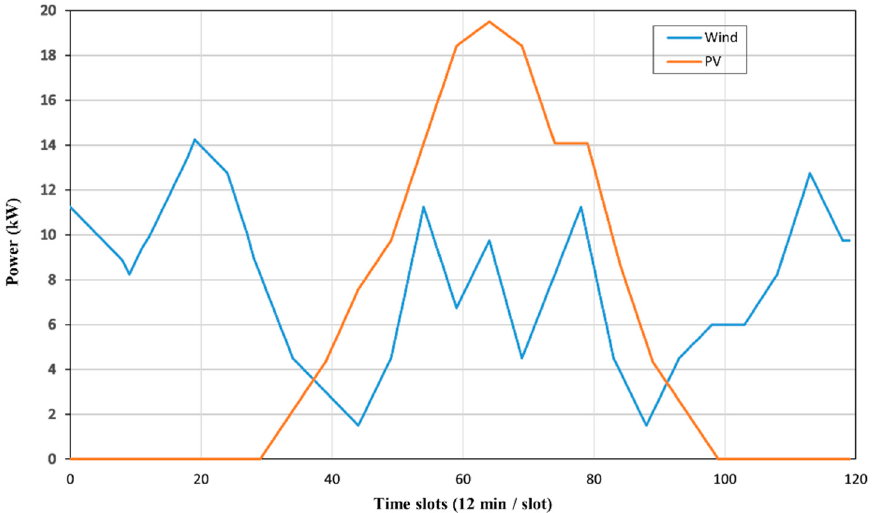
Figure 3. Power curve of wind turbine and PV system.